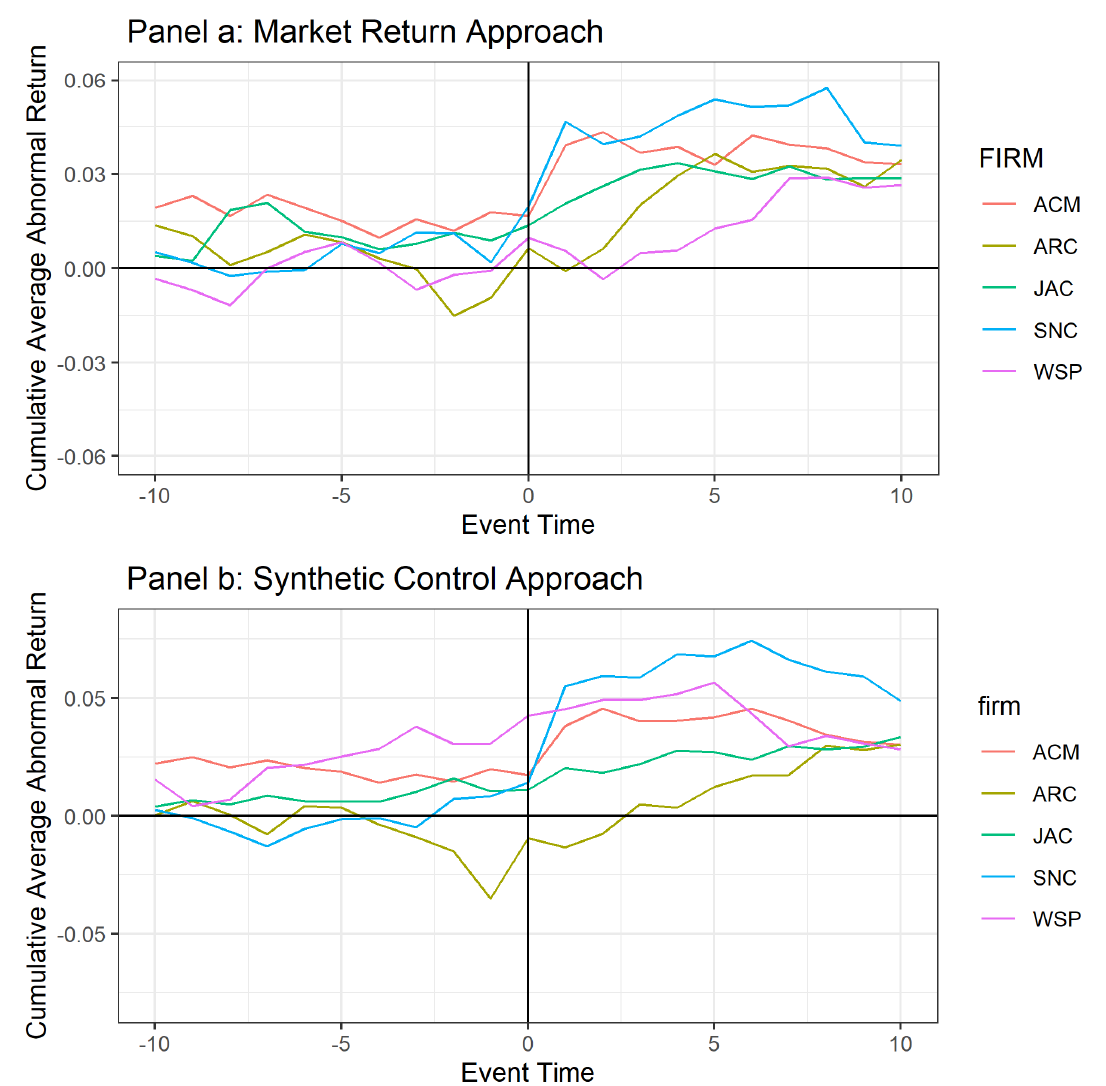
Figure 2. Dynamic of the cumulative average abnormal return by companies—event window ( − 10 days, +10 days). Notes: AECOM (ACM), Arcadis (ARC), Jacobs (JAC), SNC Lavalin (SNC), WSP Global (WSP).